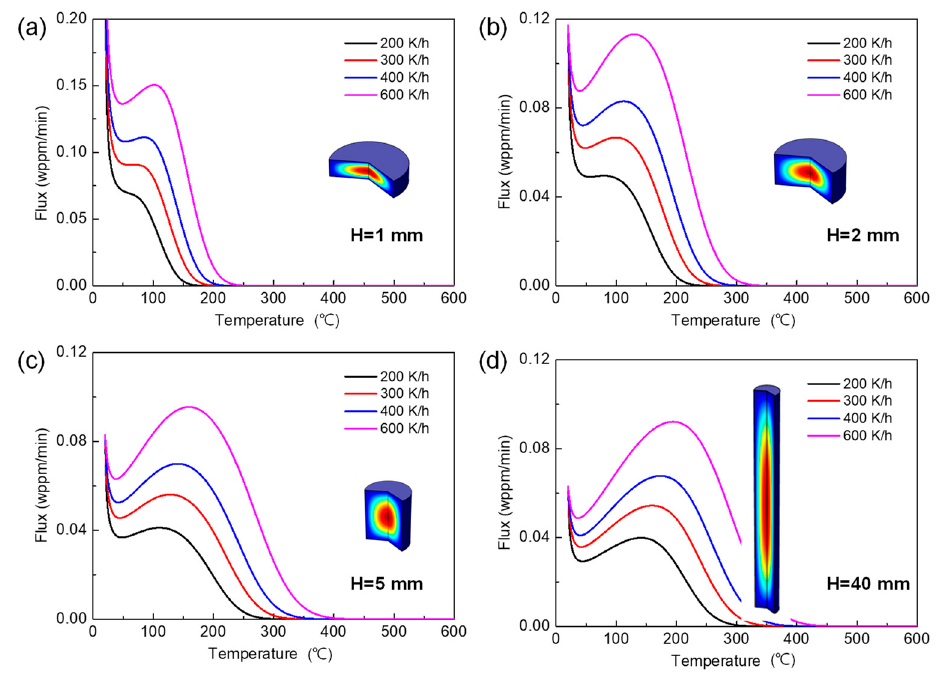
Figure 6. Desorption spectra for different specimen geometries at four different heating rates from 200 to 600 K/h, with the illustration of specimen geometries shown in the inset figures: ( a ) H = 1 mm, ( b ) H = 2 mm, ( c ) H = 5 mm, ( d ) H = 40 mm. The diameter of specimen was fixed at D = 4 mm (inset figures shown in different scales). Other parameters are same as those in Figure 2.